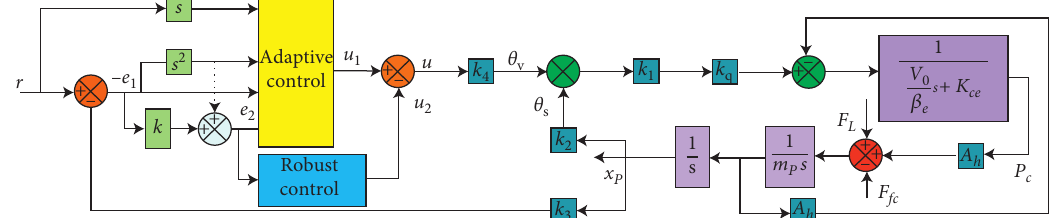
Figure 2: Simulation block diagram of adaptive friction compensation based on LuGre.